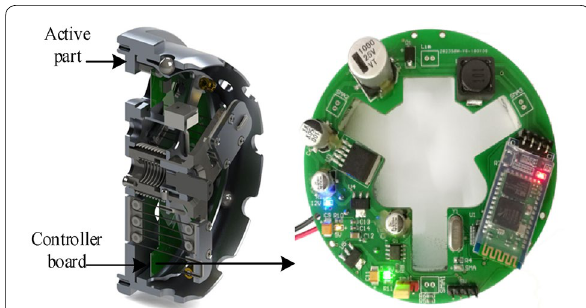
Figure 11 Control board and its installation of RCM based on SMA